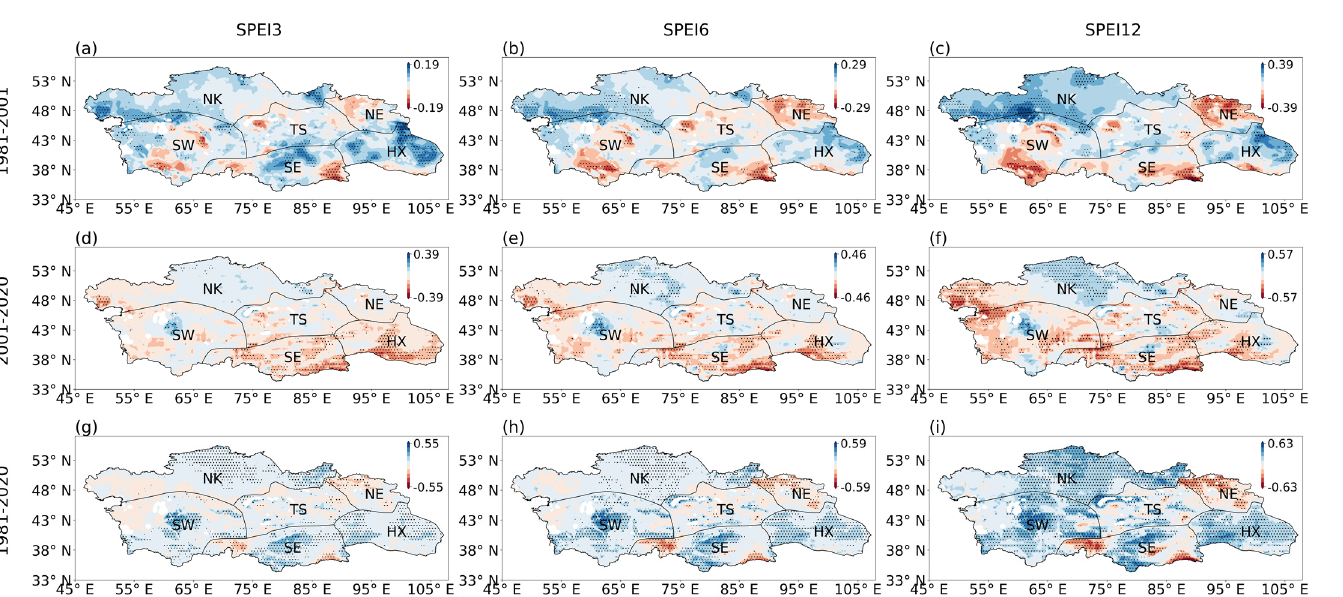
Figure 5. Drought trend for SPEI3, SPEI6, and SPEI12 based on Modified Mann–Kendall test. The dots represent the significance of drying (wetting) at the 0.05 significance level. Subplots ( a – i ) represent the drought trends in at different scales (SPEI3, SPEI6, and SPEI12) during 1981–2001, 2001–2020 and